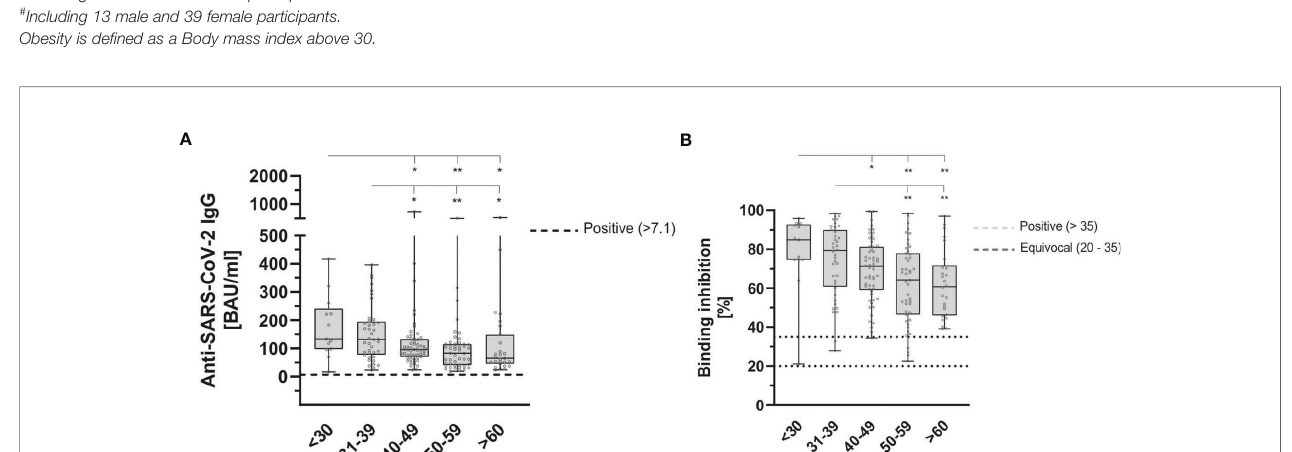
FIGURE 5 | Age dependent anti-SARS-CoV-2-IgG bindingantibodies (A) and neutralizing antibodies (B) 9 monthsafter second dose of BioNTech/P fi zer vaccine with both, signi fi cantly reduced inolder participants (p = 0.003 and p = 0.001, respectively). Anti-SARS-CoV-2-IgG antibodies were determined using a quantitative assay from Abbott. In keepingwith the WHO-standard, data were expressed inBinding Antibody Units per ml(BAU/ml).Samples were marked seronegative below 7.1 BAU/ml whereas values above 7.1 BAU/ml were determinedto bepositive (horizontal black dotted line), as mentioned by the manufacturer. Neutralizing anti-SARS-CoV-2 antibodies were determined using the NeutraLISA ™ SARS-CoV-2 Neutralization Antibody Detection KIT fromEuroimmun. According to the manufacturer,binding inhibition values above 35% were considered positive (horizontal black dotted line),whereas values between 20% and35% were considered equivocal(horizontal gray dotted line). Cohorts were grouped as follows (in years): <30 (n= 13),31-39 (n= 40),40-49 (n = 57), 50-59 (n = 47), >60 (n= 27).*p< 0.05; **p < 0.01 (Mann-Whitney